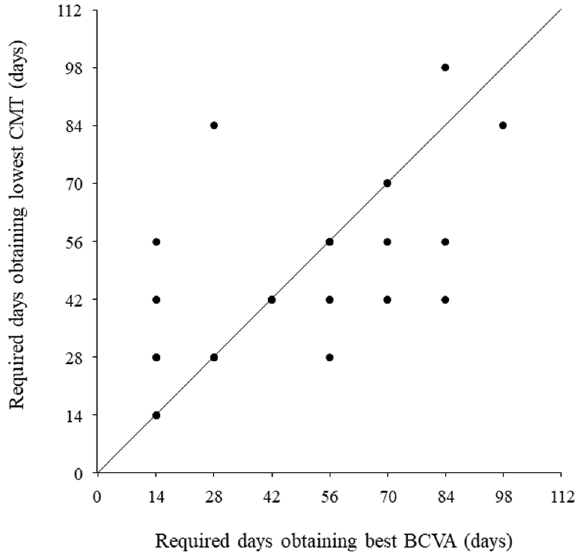
Figure 3. Time in period of efficacy (in days) until highest values of best corrected visual acuity (BCVA) and smallest value of central macular thickness (CMT). The theoretical line reflects the days with the highest BCVA value and the smallest CMT